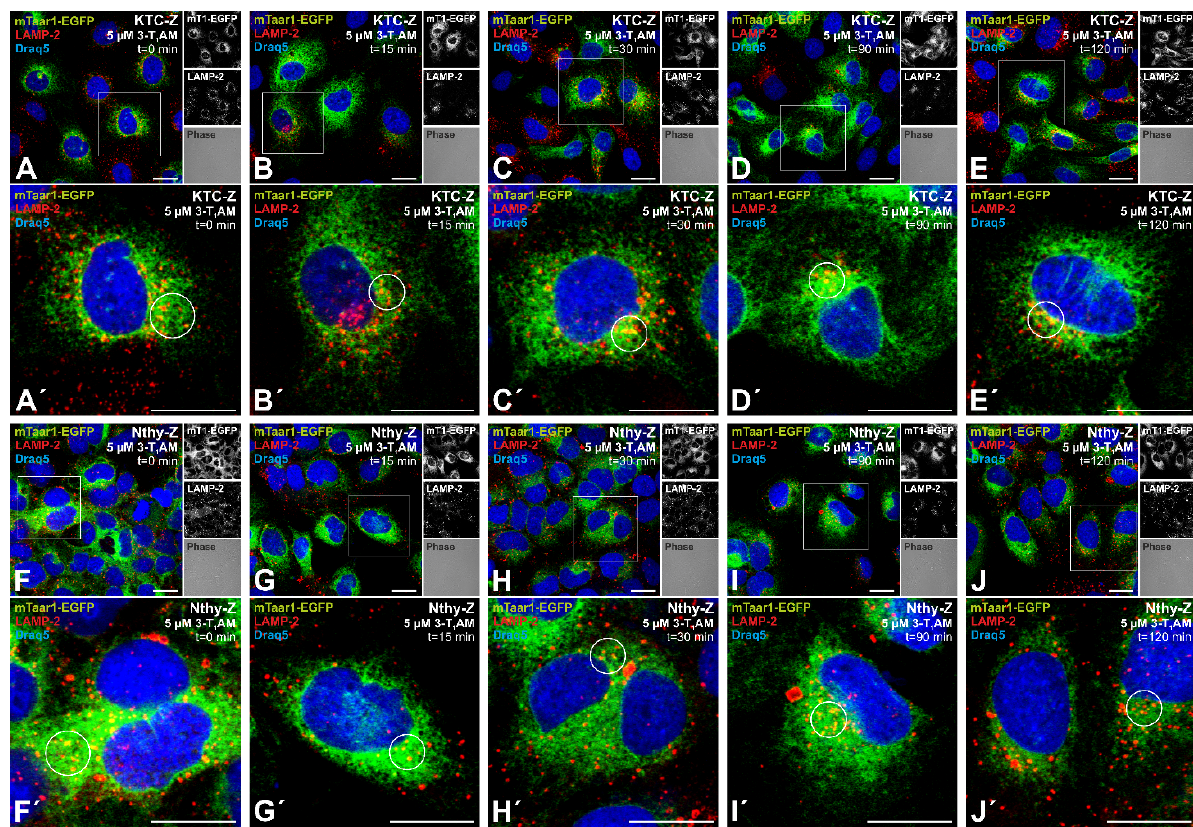
Figure 6. mTaar1-EGFP turnover is constant in steady state and not affected by ligand stimulation. KTC-Z ( A – E’ ) and Nthy- Z cells ( F – J’ ) were fixed and immunolabeled with the lysosomal marker LAMP-2 (red) at 0 min to 120 min after stimulation with 5 µ M 3-T 1 AM, a potential ligand of TAAR1/Taar1 in the thyroid gland. The boxed areas in A – K are magnified in A’ – J’ , respectively. mTaar1-EGFP (green) partially co-localized with LAMP-2 (red) in endo-lysosomal compartments (yellow) at all time intervals. Circles denote vesicles in which mTaar1-EGFP is seen to co-localize with LAMP-2. Draq5™ was used as nuclear counter-stain. Merged fluorescence ( A – J , A’ – J’ ) and corresponding single channel fluorescence and phase contrast micrographs are provided in the right panels of ( A – J ), respectively, as indicated. Scale bars represent 20 µ